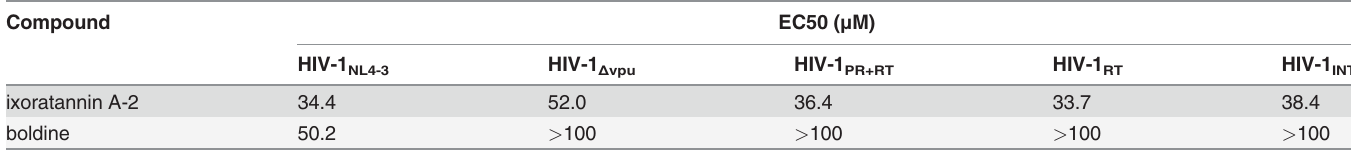
Table 3. Calculated EC 50 s of ixoratannin A-2 and boldine on HIV-1 Δ vpu and ARV-resistant HIV-1 strains.